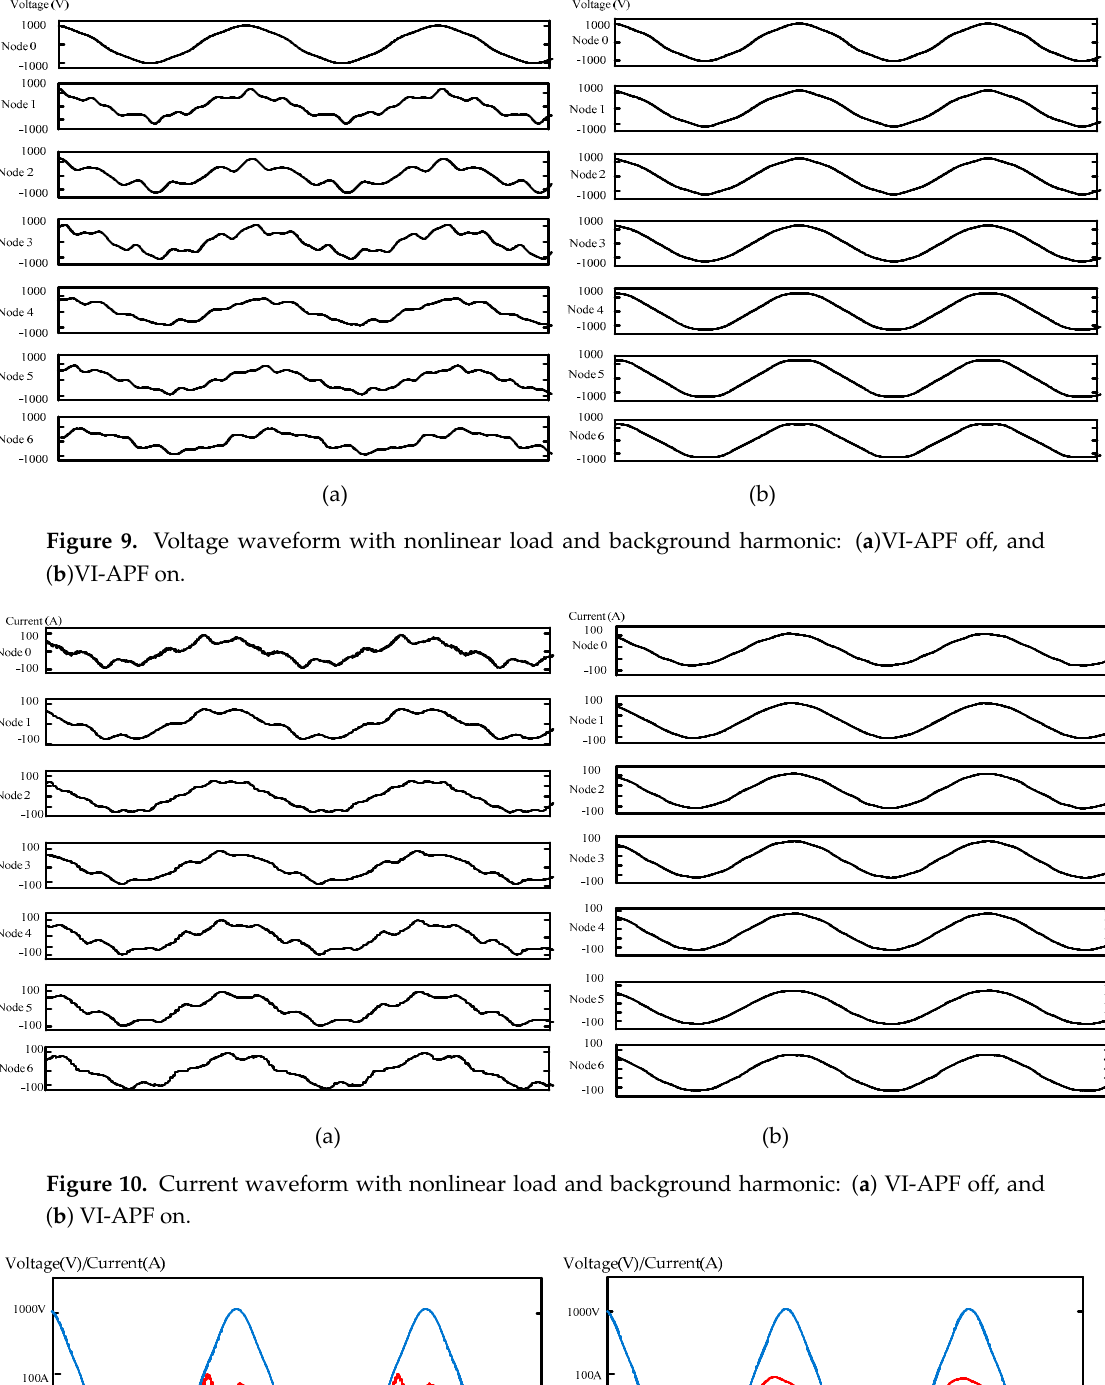
Figure 8. THD with nonlinear load and background harmonic: ( a ) current, and ( b )voltage.